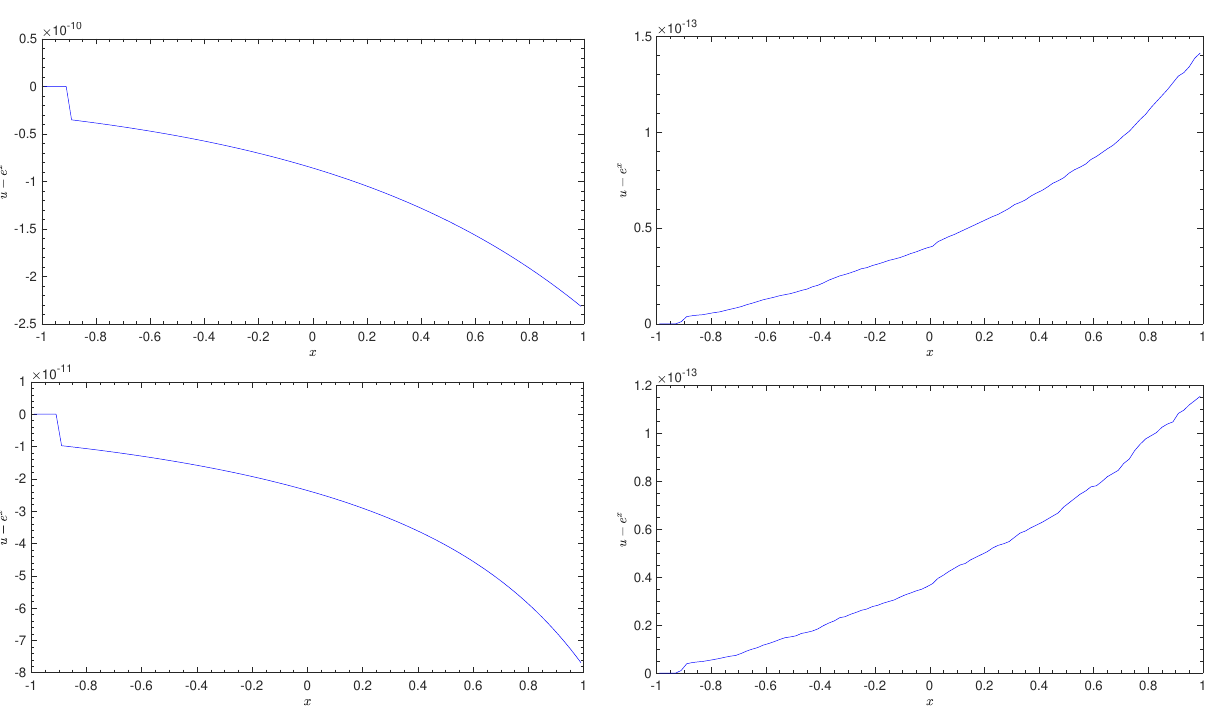
Figure 2. Fluctuation with respect to the stationary solution ( u − e H ) (45) for the Burgers’ equation at time t = 10 s with the fourth order non well-balanced ( left ) and well-balanced ( right ) methods. An uniform Cartesian mesh of N x = 100 elements has been used. Upper and lower panels stands for Runge–Kutta and ADER time marching discretisations